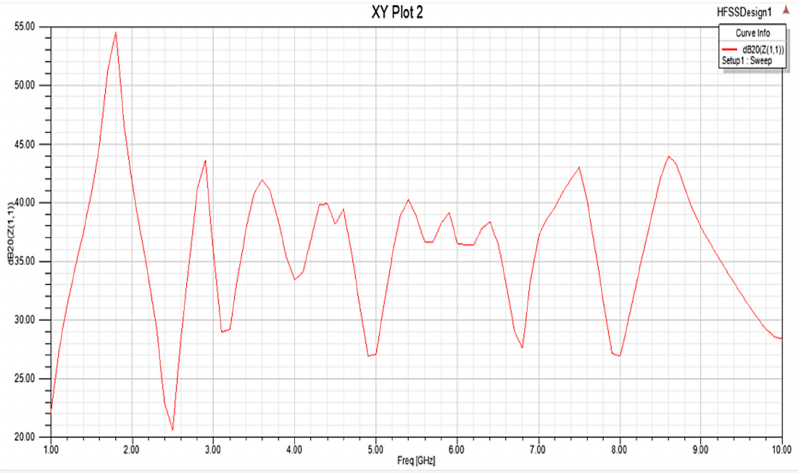
Figure 12. Impedance spectrum of multi-stacked DRA. Math. Comput. Appl. 2023 , 27 , x FOR PEER REVIEW